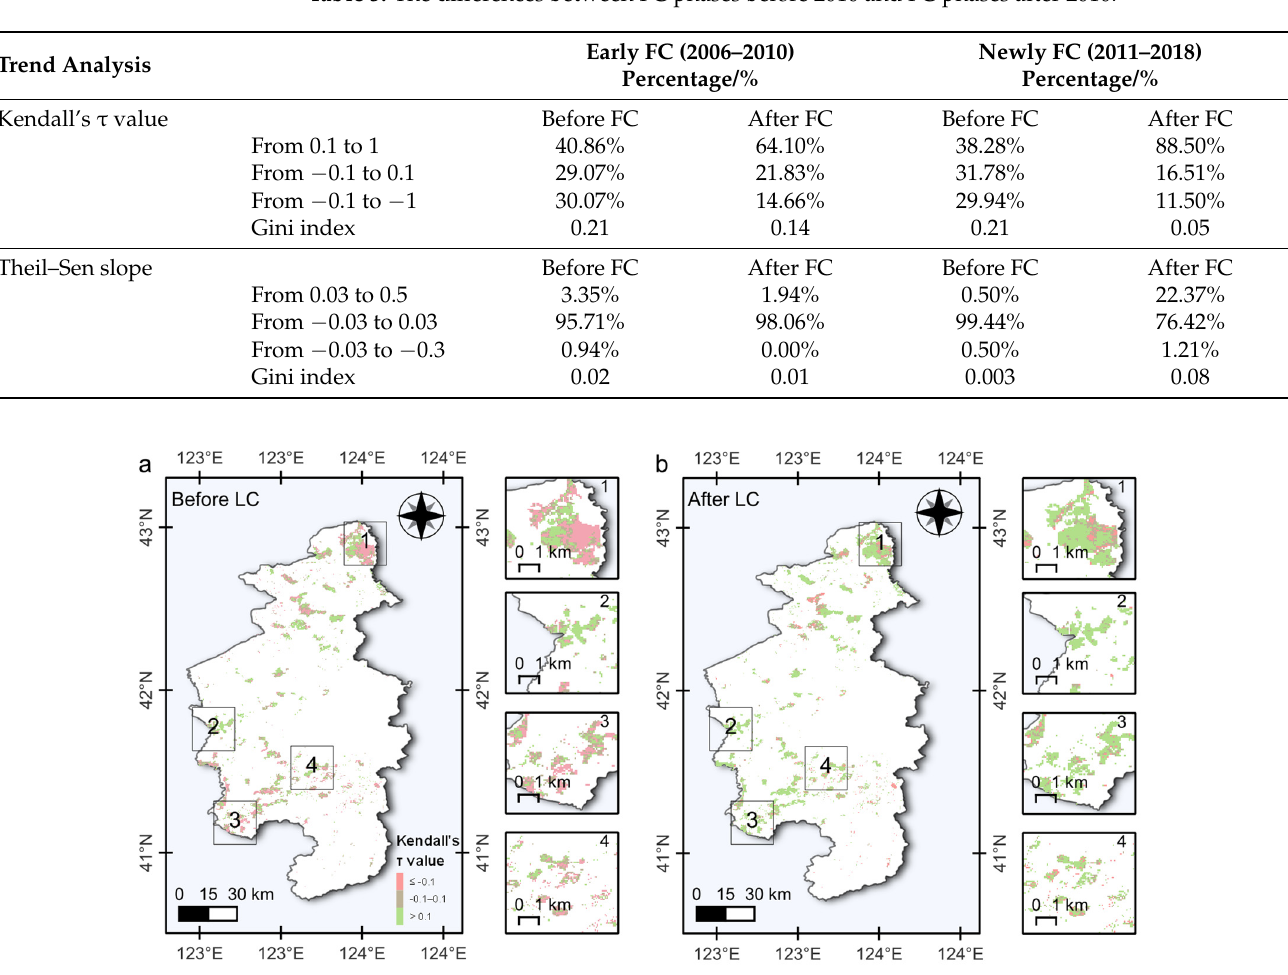
Table 3. The differences between FC phases before 2010 and FC phases after 2010.